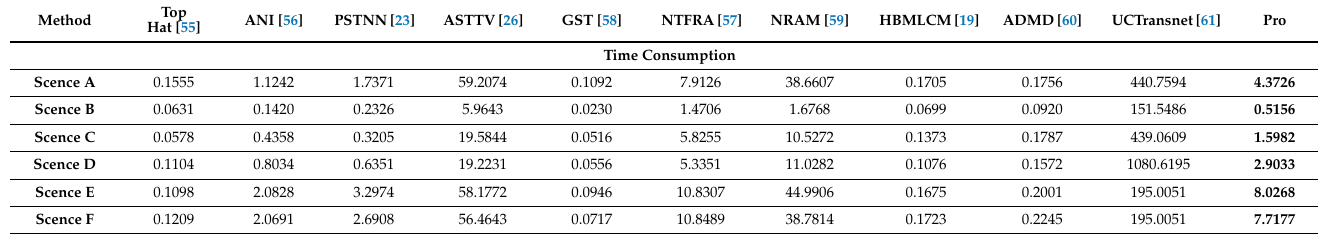
Table 11. Calculation of background modeling complexity in different scenarios of each model (unit: